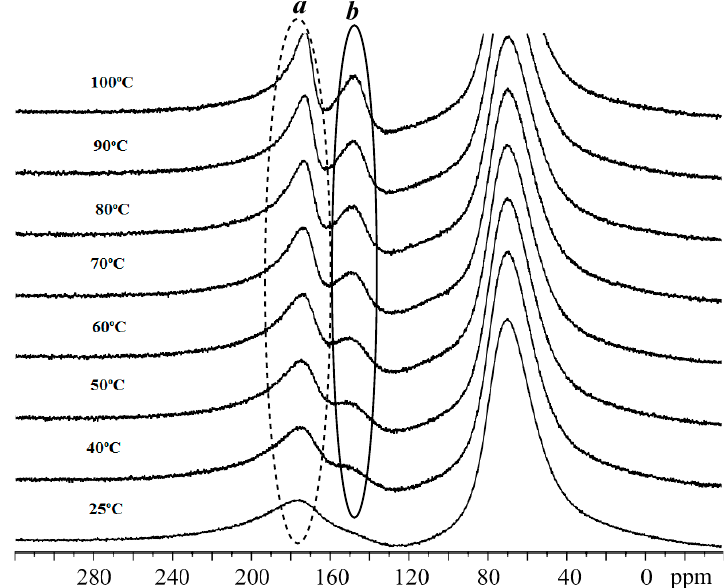
8 ). Polymers 2018 , 10 , x FOR PEER REVIEW